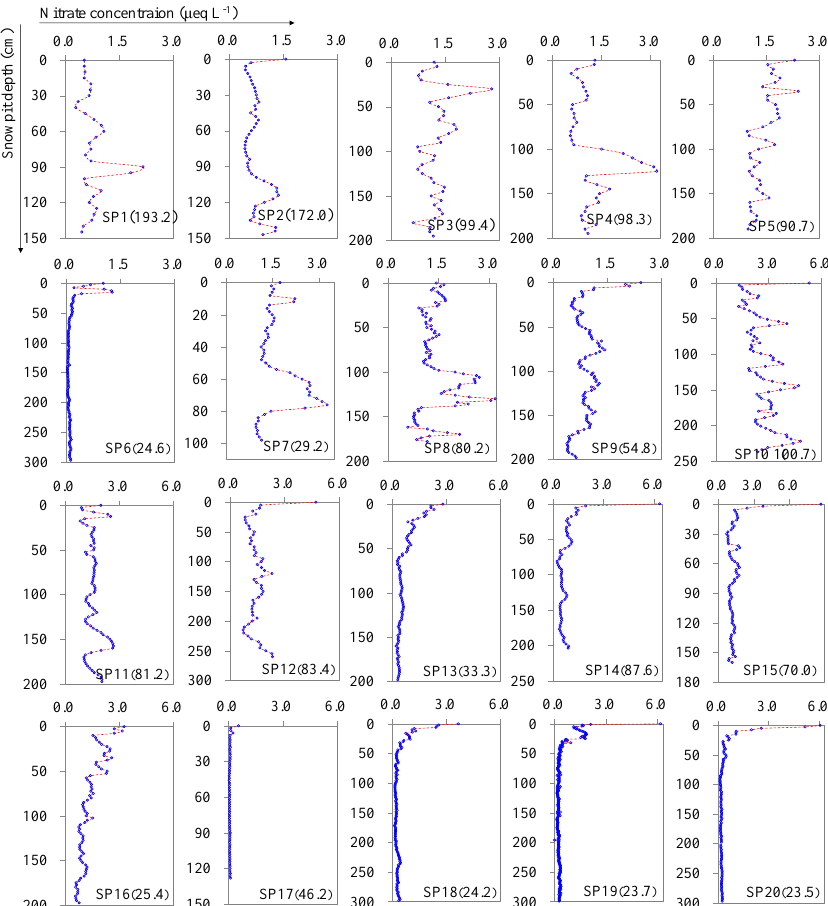
Figure 3. The full profiles of NO 3 − concentrations for snow pits collected on the traverse from the coast to Dome A, East Antarctica (SP1 is closest the coast; SP20 the furthest inland; see Fig. 2). The details on sampling of the snow pits refer to Table 1. The numbers in parentheses in each panel denote the annual snow accumulation rates (kgm − 2 a − 1 ) . Note that the scales of x axes for the snow pits SP1–SP9 and SP10–SP20 are different.